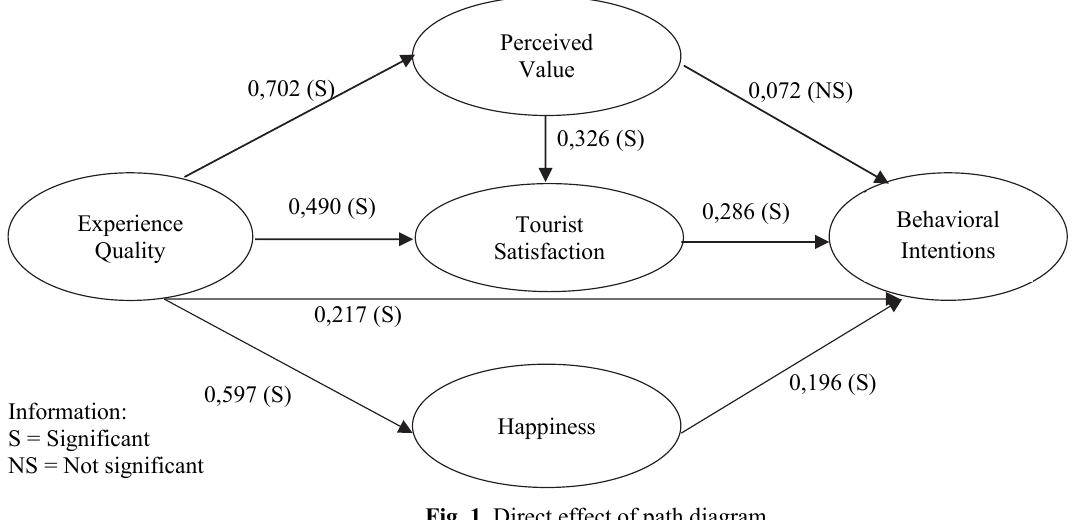
Fig. 1. Direct effect of path diagram